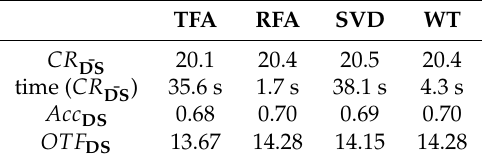
Table 2. Results of compression, classification and OTF (optimal transmission